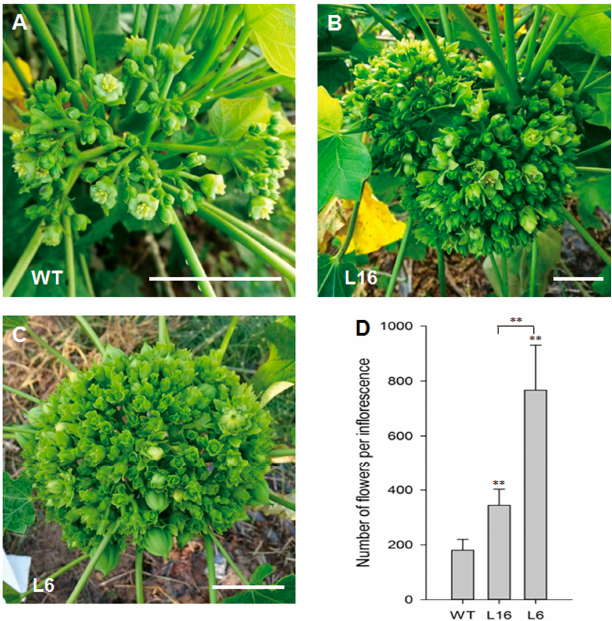
Figure 3. The flower number per inflorescence was increased in JcTM6:AtIPT4 transgenic J. curcas . ( A – C ) Inflorescences of WT plants ( A ) and the transgenic lines L16 ( B ) and L6 ( C ); scale bars = 3 cm. ( D ) Number of flowers per inflorescence in WT and transgenic J. curcas . The values represent the means ± standard deviations ( n = 8). Student’s t -test was used for the statistical analyses: ** p ≤